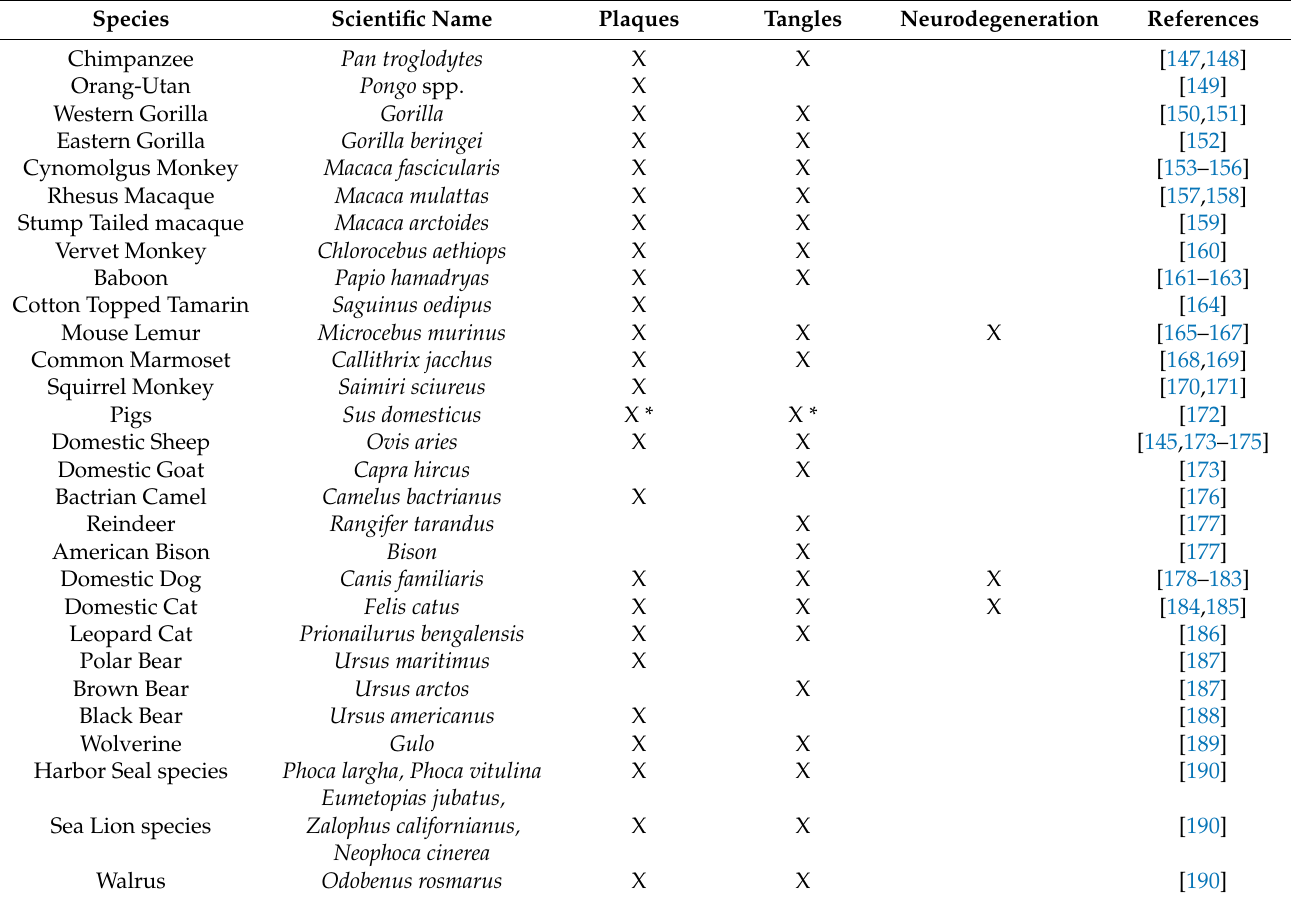
Table 2. A summary of the large animals in which plaque, tangle pathology, or neurodegeneration with older age has been identified.